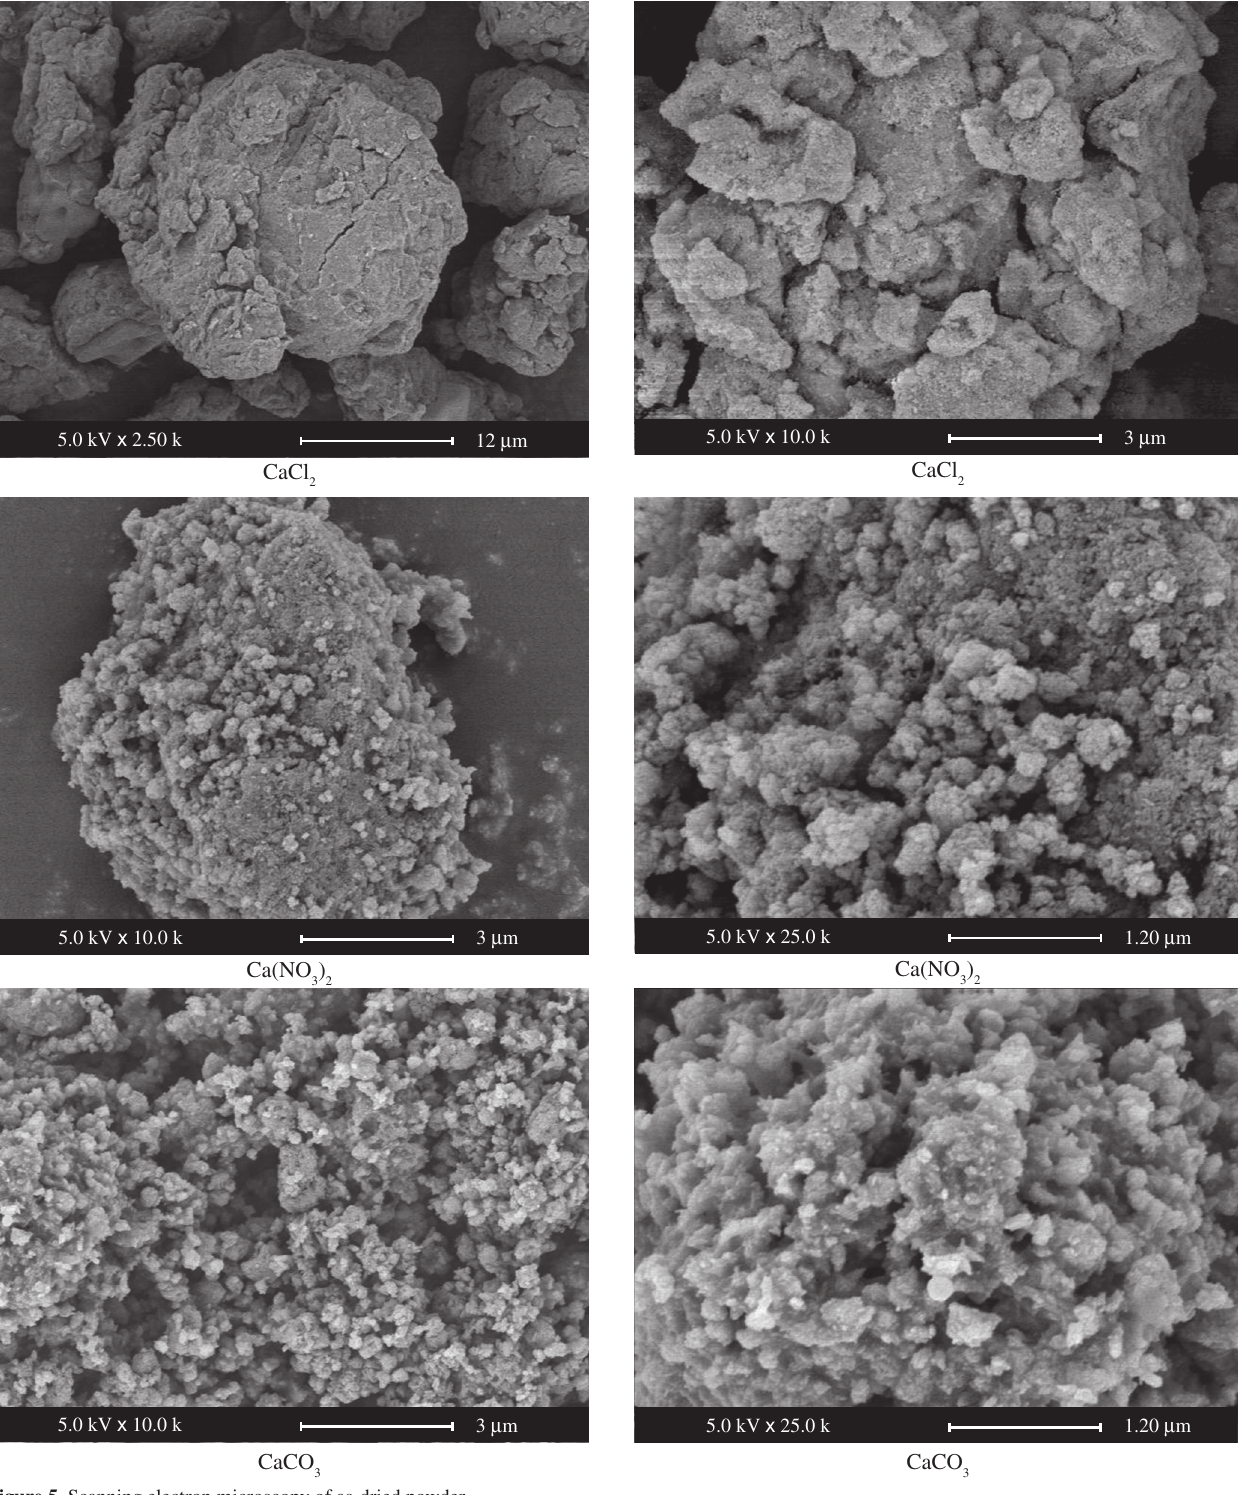
Figure 5. Scanning electron microscopy of as-dried